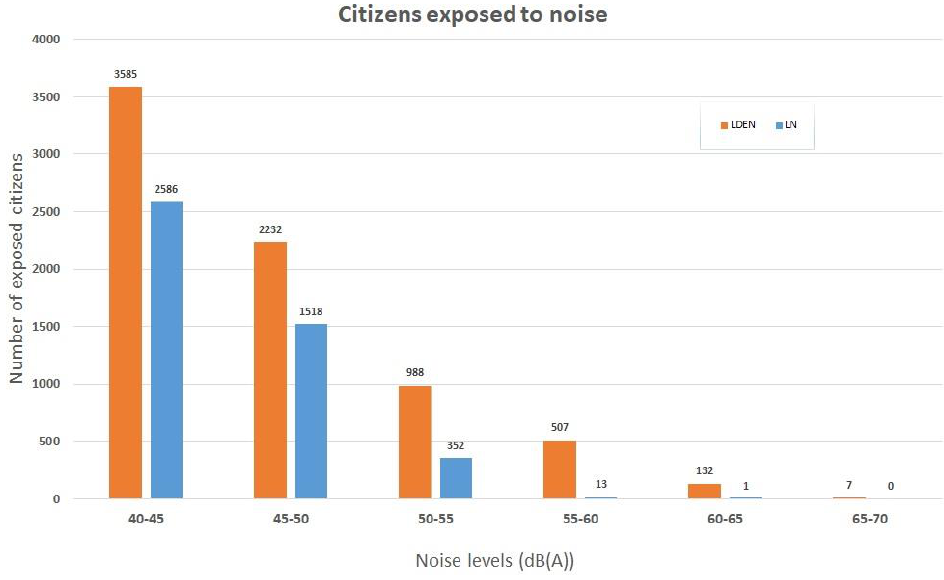
Figure 9. Number of citizens exposed to noise levels above 40 dB(A) L DEN or L N in Scenario 3.